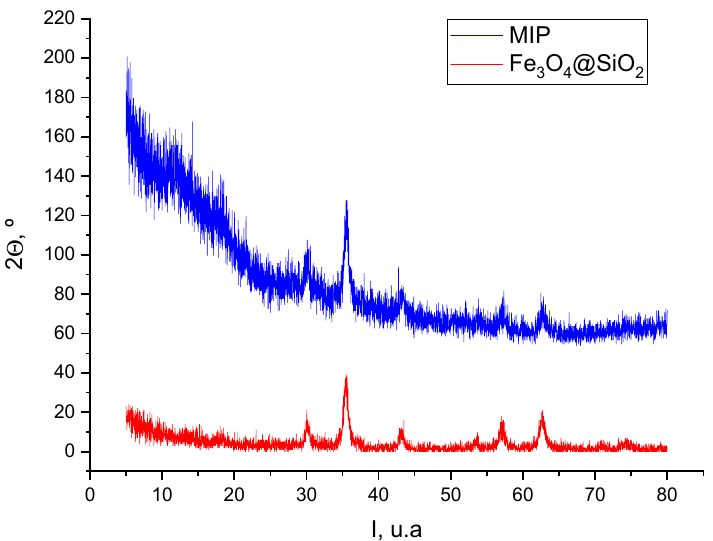
Figure 6. X-ray diffraction spectra of magnetic nanoparticles before (red line) and after (blue line) the polymerization process.